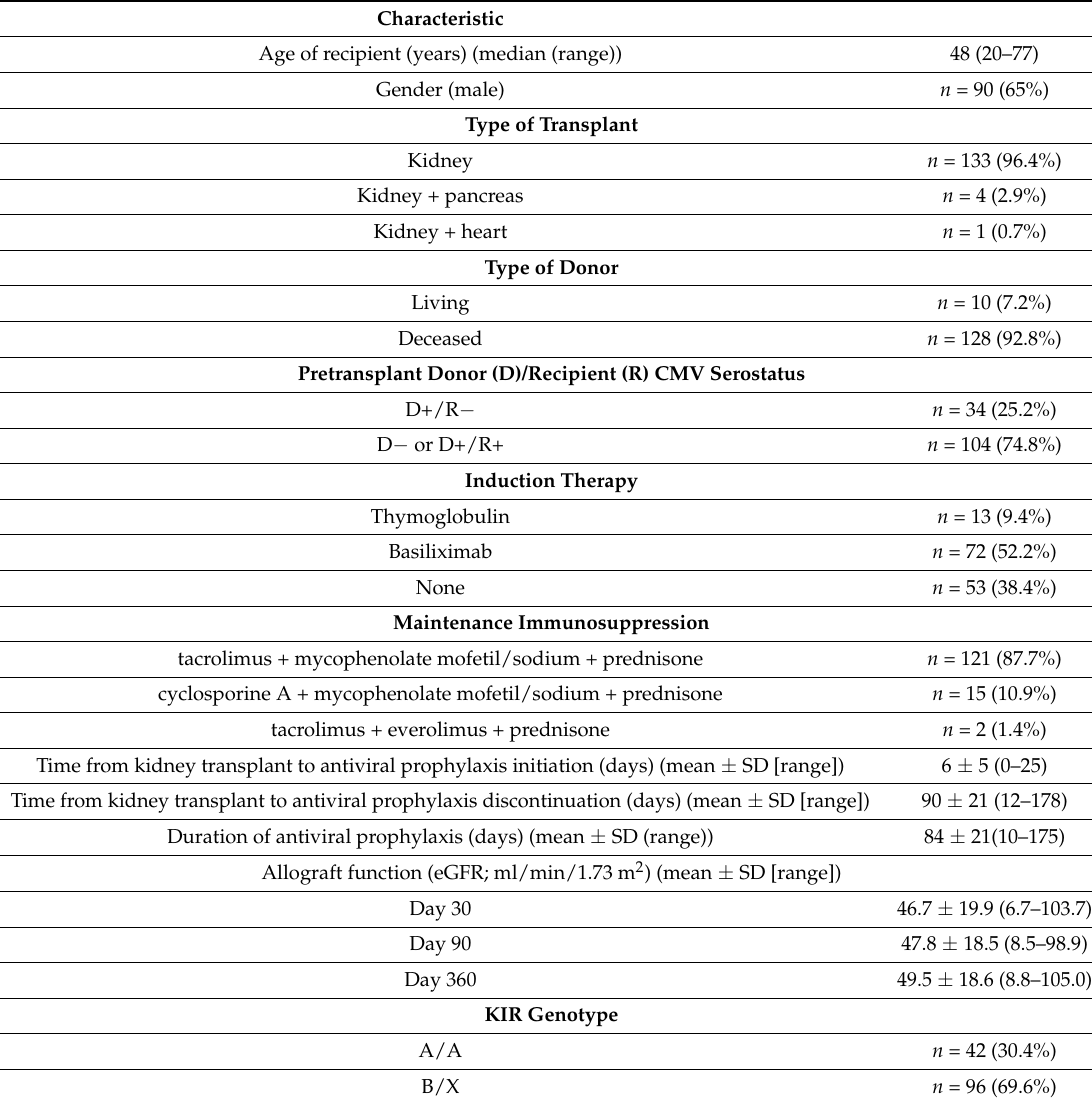
Table 1. Baseline characteristics of the study patients.